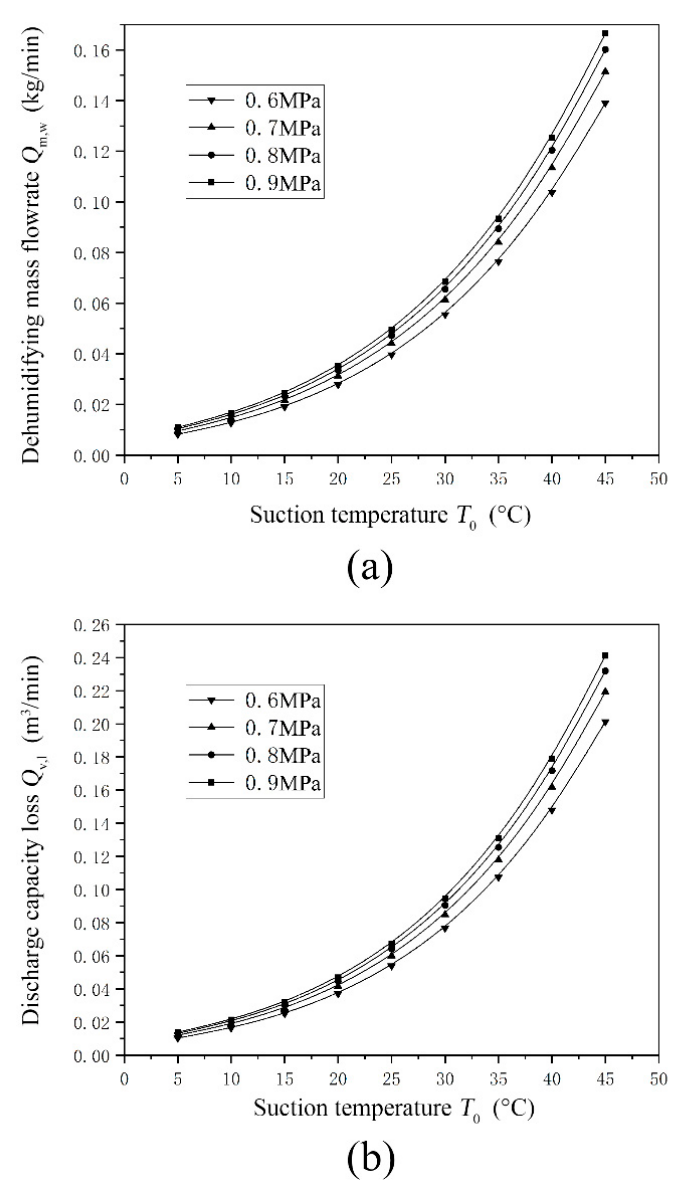
Figure 7. The influence of suction temperature on the dehumidifying process: ( a ) dehumidifying mass flow; ( b ) loss of discharge capacity.